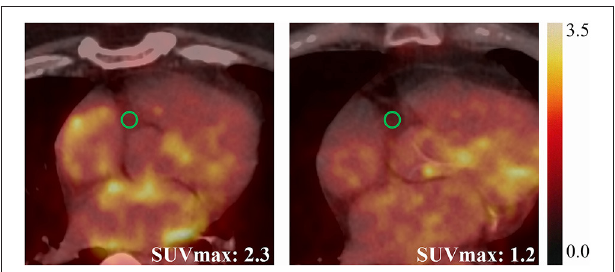
FIGURE 1 | Representative cases showing elevated EAT activity (SUV max = 2.3) in a 57-year-old male PsAF patient (left), and normal EAT activity (SUV max = 1.2) in an 80-year-old male PAF patient (right).